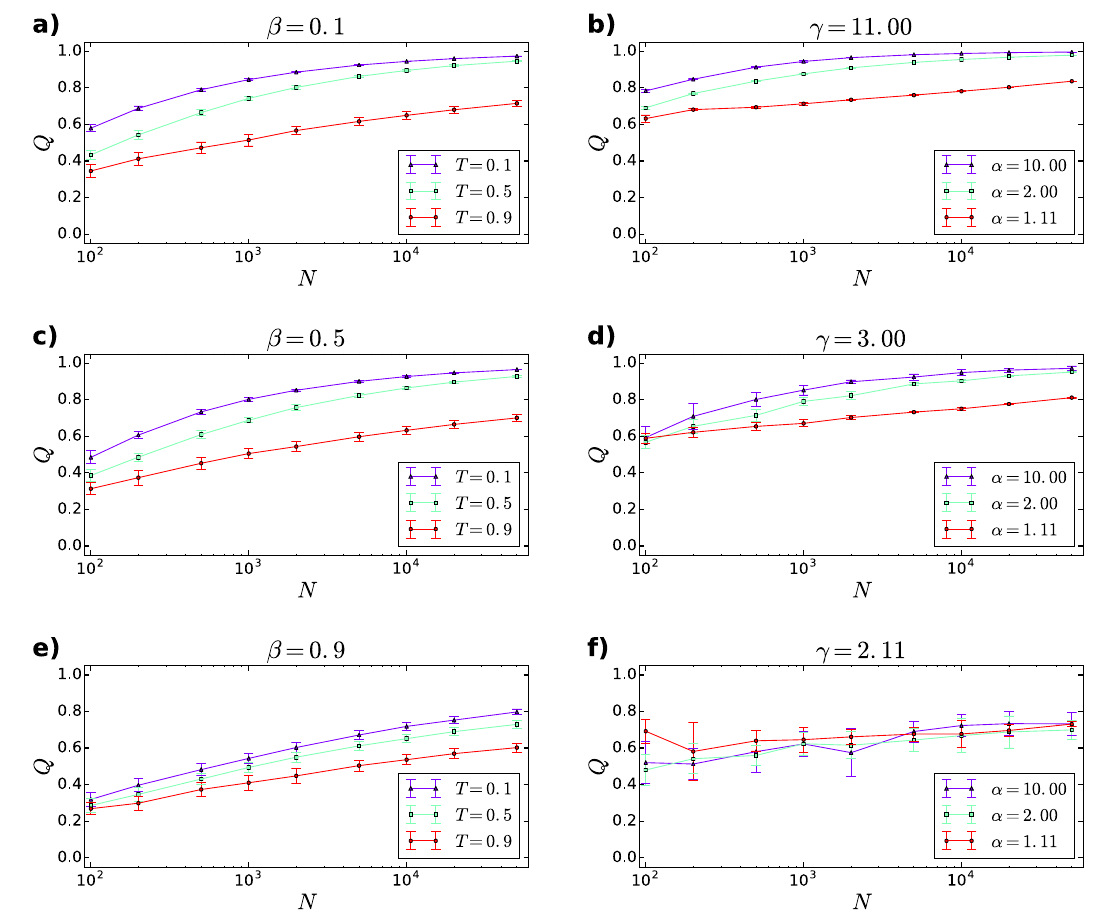
Figure 5. Size dependence of the modularity in the PSO model and the S 1 / H 2 model. We plotted the highest weighted modularity Q achieved between the asynchronous label propagation, the Louvain and the Infomap algorithms, as a function of the number of nodes N . The panels on the left display the results for the PSO model, whereas the panels on the right correspond to the S 1 / H 2 model. The expected average degree in each case. The further model parameters, such as the β , T , α and γ values appear as panel titles and legends. Each data point was obtained by averaging over 10 networks of the given parameter set. The error bars indicate the standard deviations among the 10